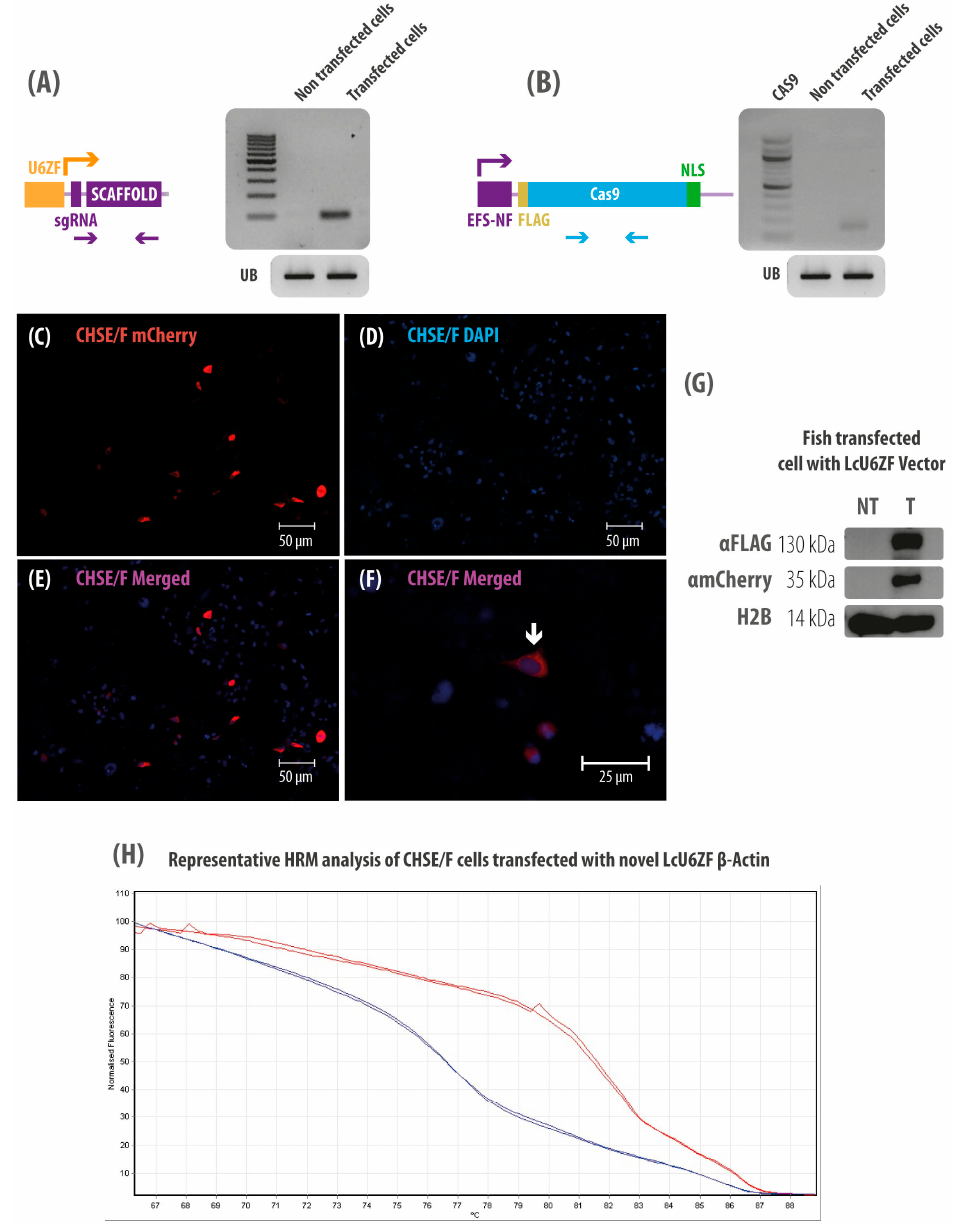
Figure 2. Expression of the sgRNA, Cas9, and mCherry in CHSE/F transfected cells. ( A , B ) RT-PCR analysis of the sgRNA (96 bp) and Cas9 (131 bp) expression, respectively. Expression was normalized with the ubiquitin housekeeping gene (image located below, 205 bp). ( C – F ) Microscopy of fluorescence imaging. Arrow depicts the mCherry expressing cells at 96 h post-transfection. Bar = 25 and 50 µ m. ( G ) Western blot analysis of Cas9 and mCherry in CHSE/F transfected cell. The Cas9 and mCherry proteins were immunodetected using a FLAG antibody (130 kDa) and mCherry antibody (35 kDa), respectively. H2B serves as a loading control (14 kDa). ( H ) Red lines depict the non-transfected melting curve or wild type, whereas the blue melting curve represents the thermal profile of CHSE/F transfected cells. Both samples are biological replicates. Fluorescence difference curves are automatically grouped by the HRM curve analysis system.